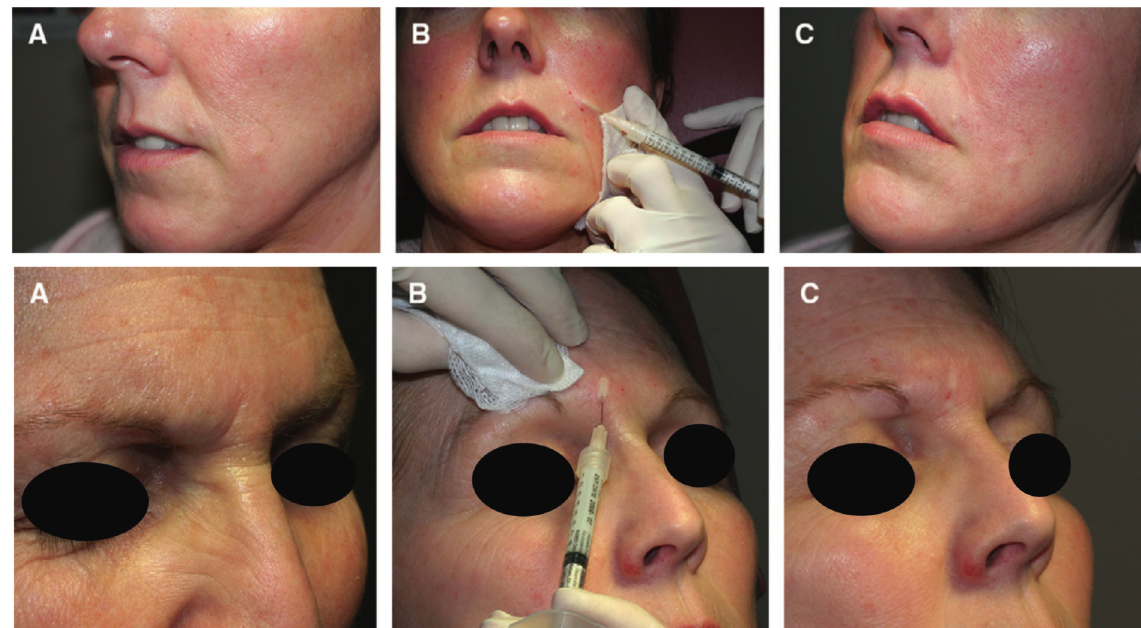
Figure 5: (a) Nasolabial fold fine lines and glabellar lines before collagen injection. (b) During collagen superficial injection, skin blanching is observed. (c) Immediately after collagen injection, remarkable results can be observed